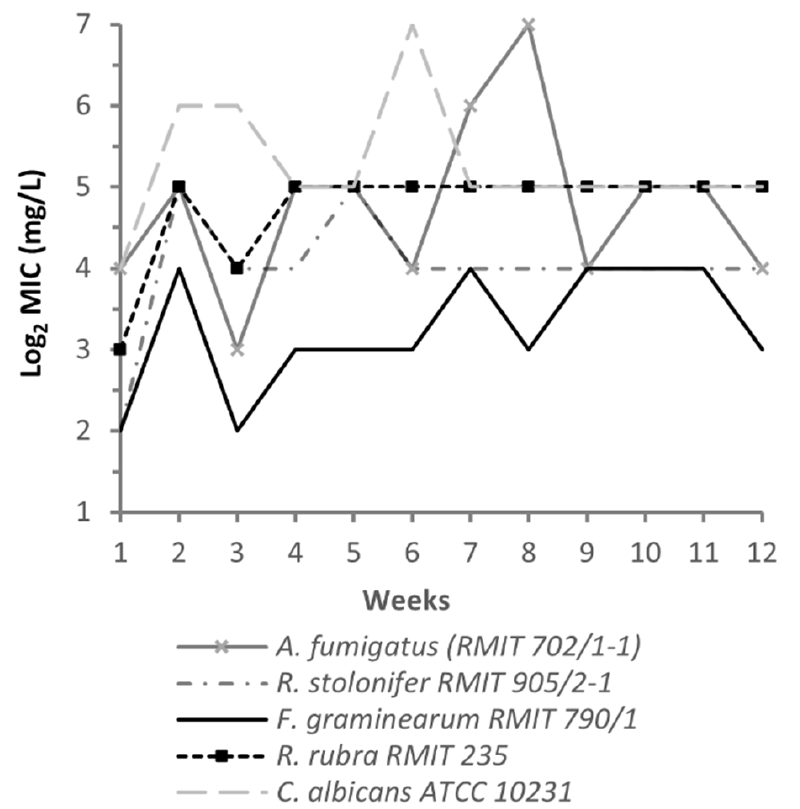
Figure 3. Resistance to NPBD in fungal strains on 12-week exposure. Test species were inoculated into NPBD 2-fold dilution sets (0.25 to 256 mg/L + 1% DMSO in SLM) (W 0 ), incubated at 25 °C for 2 d then to 7 d, and subcultured weekly into fresh dilution sets to obtain 7-day MIC (MIC W1 to MIC W12 ). Colonies from W 13 were serially subcultured 3 times in drug free medium to end of W 13